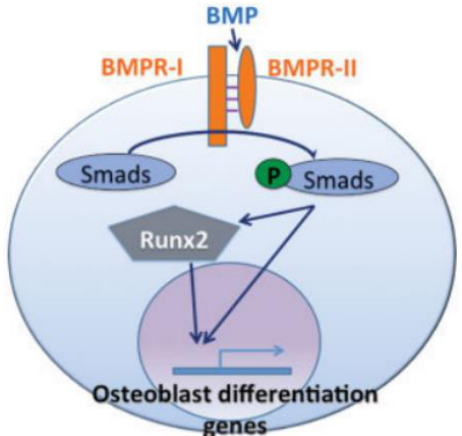
Figure 4. Bioengineering 2020 , 7 , x FOR PEER